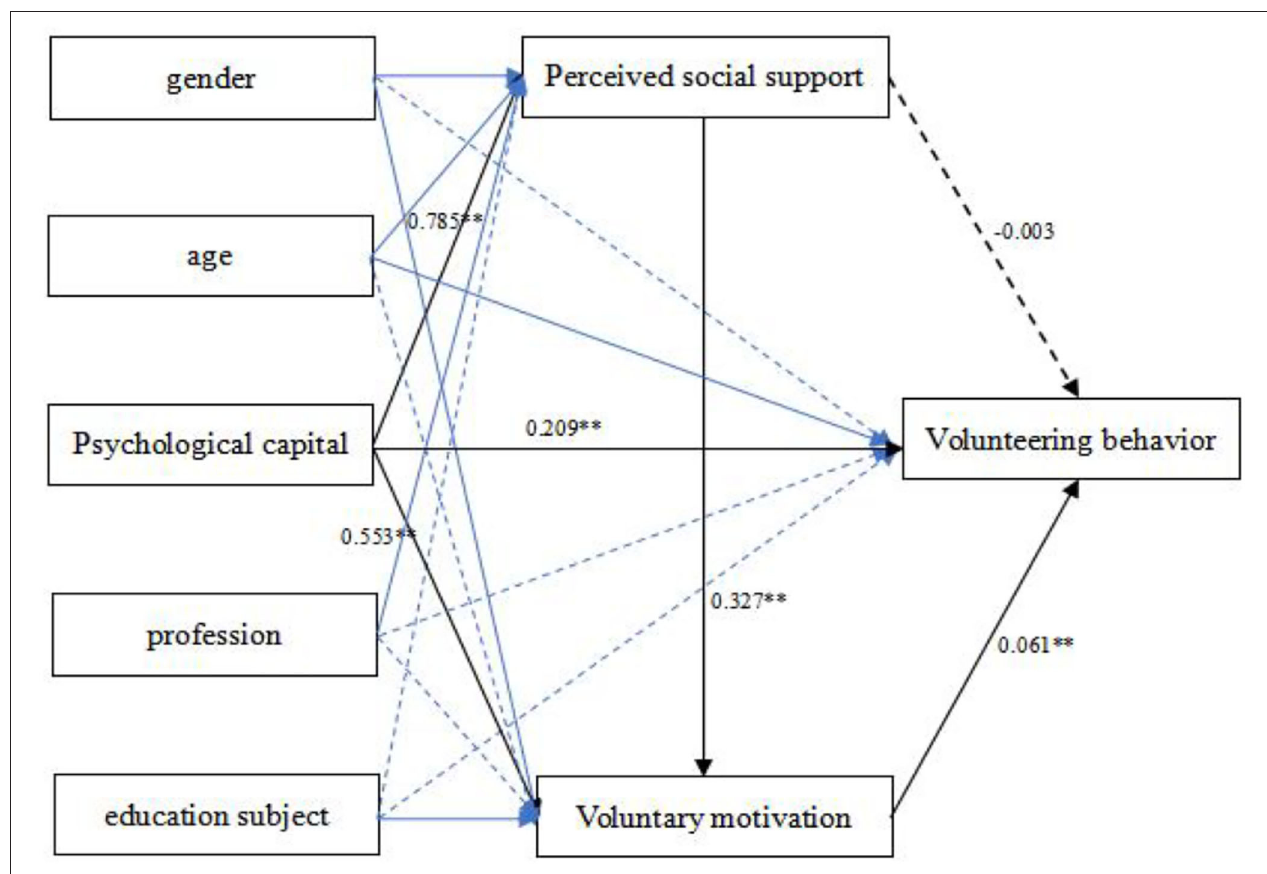
FIGURE 2 | Chained mediation diagram. The solid line in the influence of demographic variables on each factor indicates p < 0.05; the dashed line indicates p > 0.05. The numbers in the figure indicate the path coefficients. * p < 0.05; ** p <